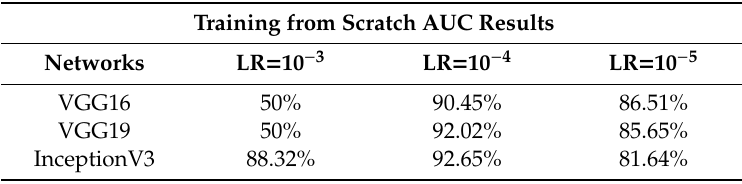
Table 9. Results of di ff erent architectures trained from scratch using the BreakHis